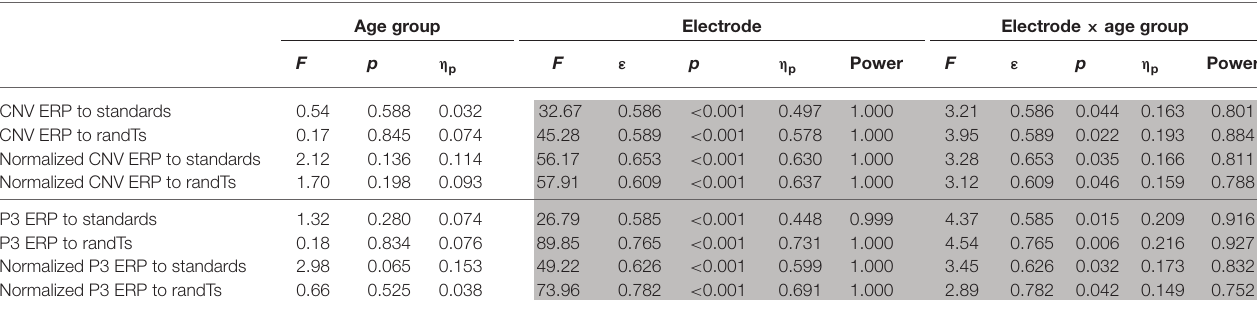
TABLE 1 | Effect of electrode and age group on the ERP